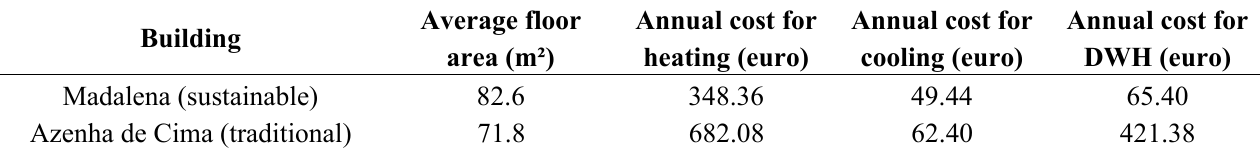
Table 6. Average expectable energy costs per dwelling—Madalena vs . Azenha de Cima.